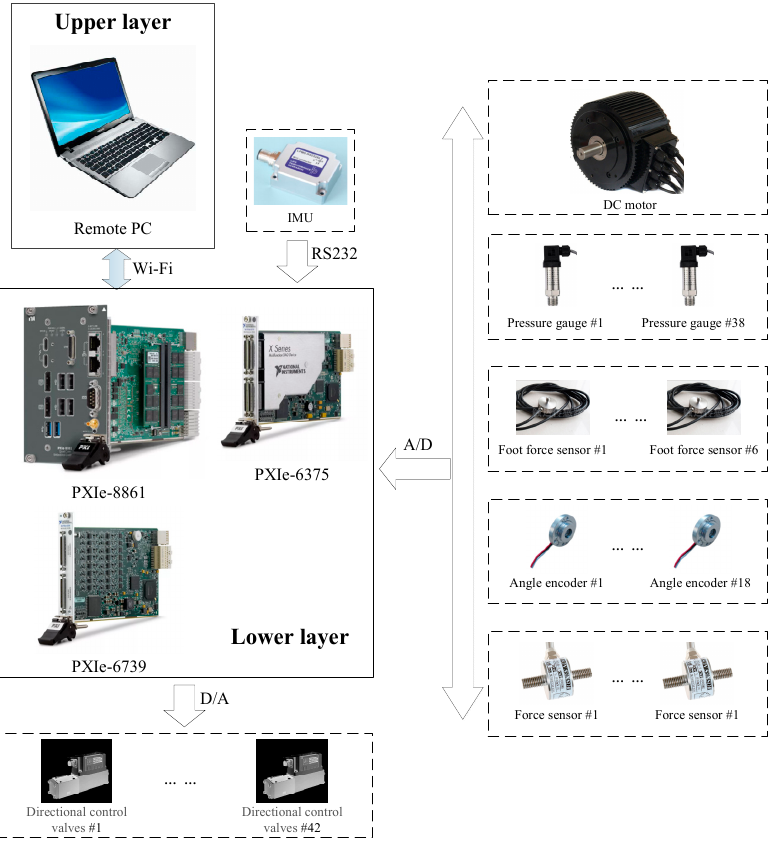
Figure 3. Configuration of HHR control system. Table 1. List of specifications of different sensors.